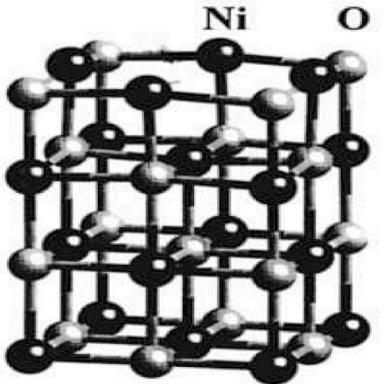
Crystal structure of NiO.